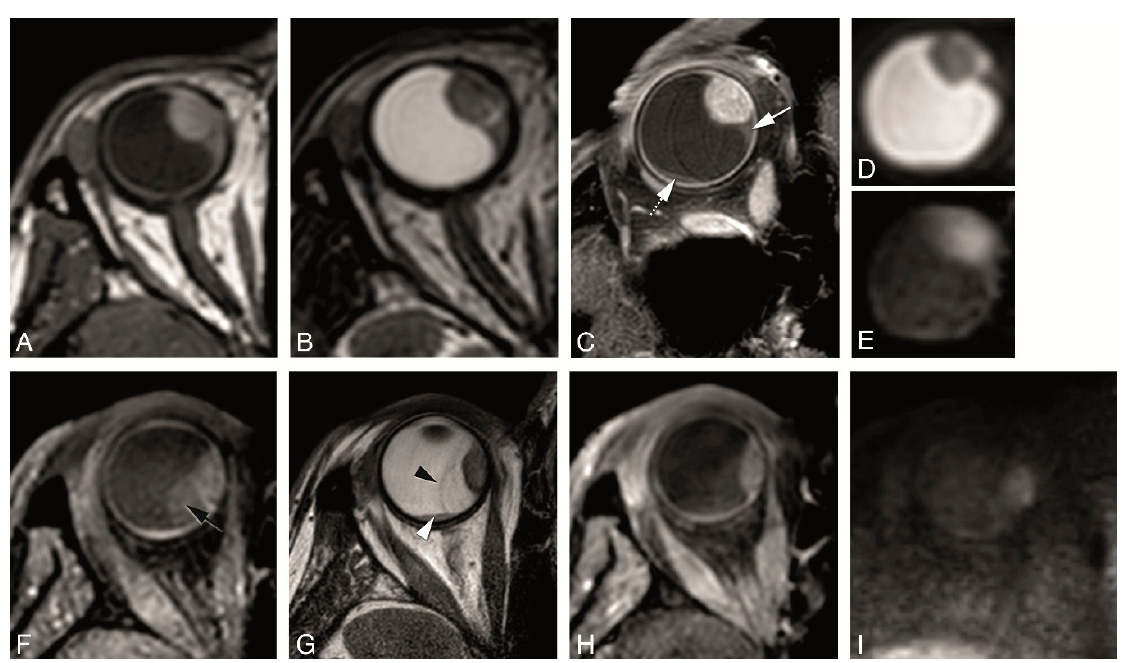
Figure 10. ( A – I ) Retinal detachment in two different patients. ( A – E ) MS 1 mm axial T1 ( A ), MS 1 mm axial T2 ( B ), MS 2 mm enhanced axial oblique T1 with fat signal suppression ( C ), DWI with b values of 0 s/mm 2 ( D ) and 800 s/mm 2 ( E ). Small homogeneous retinal detachment (arrow) located adjacent to the tumor, but also posterior and temporal (dashed arrow). It is distinguished from the tumor due to no enhancement, no diffusion restriction and a lentiform shape. ( F – I ) MS 1 mm axial T1 with fat signal suppression ( F ), MS 2 mm axial T2 ( G ), MS 1 mm enhanced axial T1 with fat signal suppression ( H ) and DWI with b value of 800 s/mm 2 ( I ). Large heterogeneous retinal detachment. One bigger component which is better seen on T1 without contrast (black arrow), while on T2 only the retina being seen (black arrowhead) and the content being similar to the vitreous. One smaller component better seen on T2 (arrowhead), and due to being hemorrhagic hyperintense on T1 and with slight diffusion